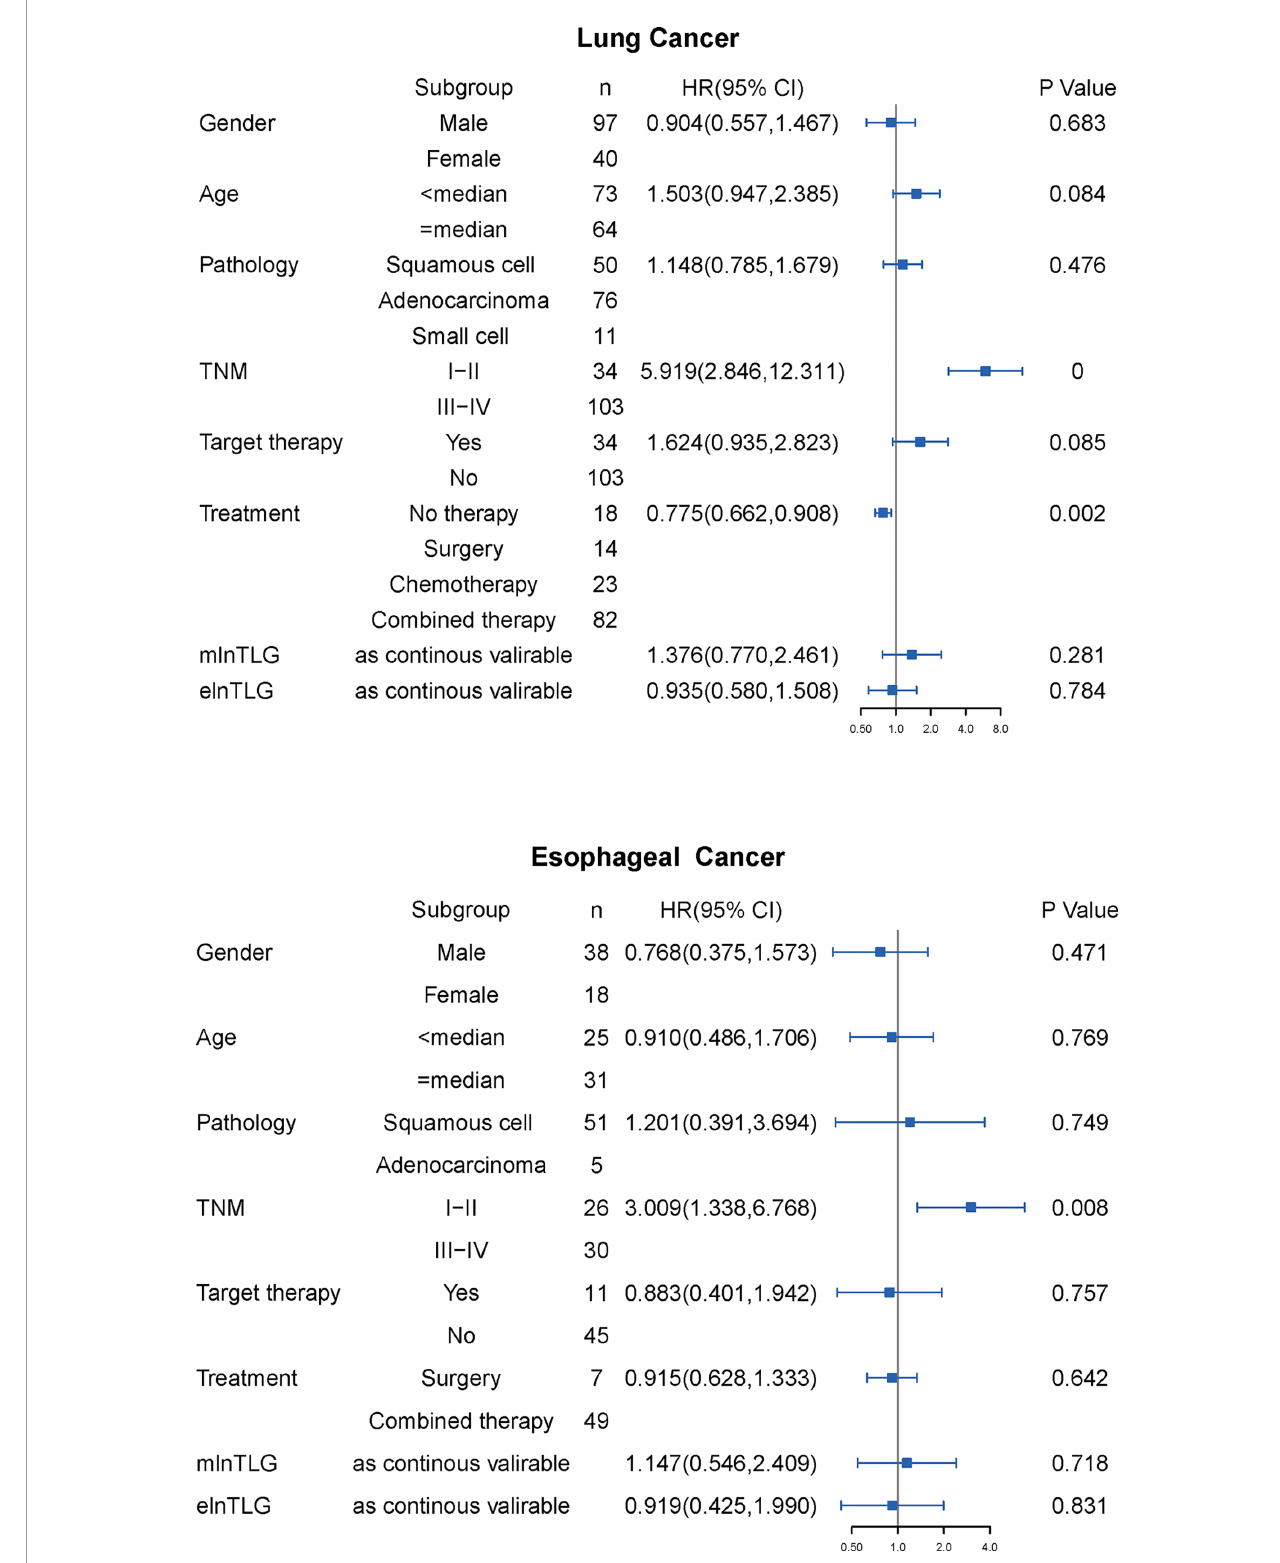
FIGURE 3 | Results of univariate Cox regression analysis for lung cancer (upper) and esophageal cancer (lower). HR with 95% CI is plotted in the fourth